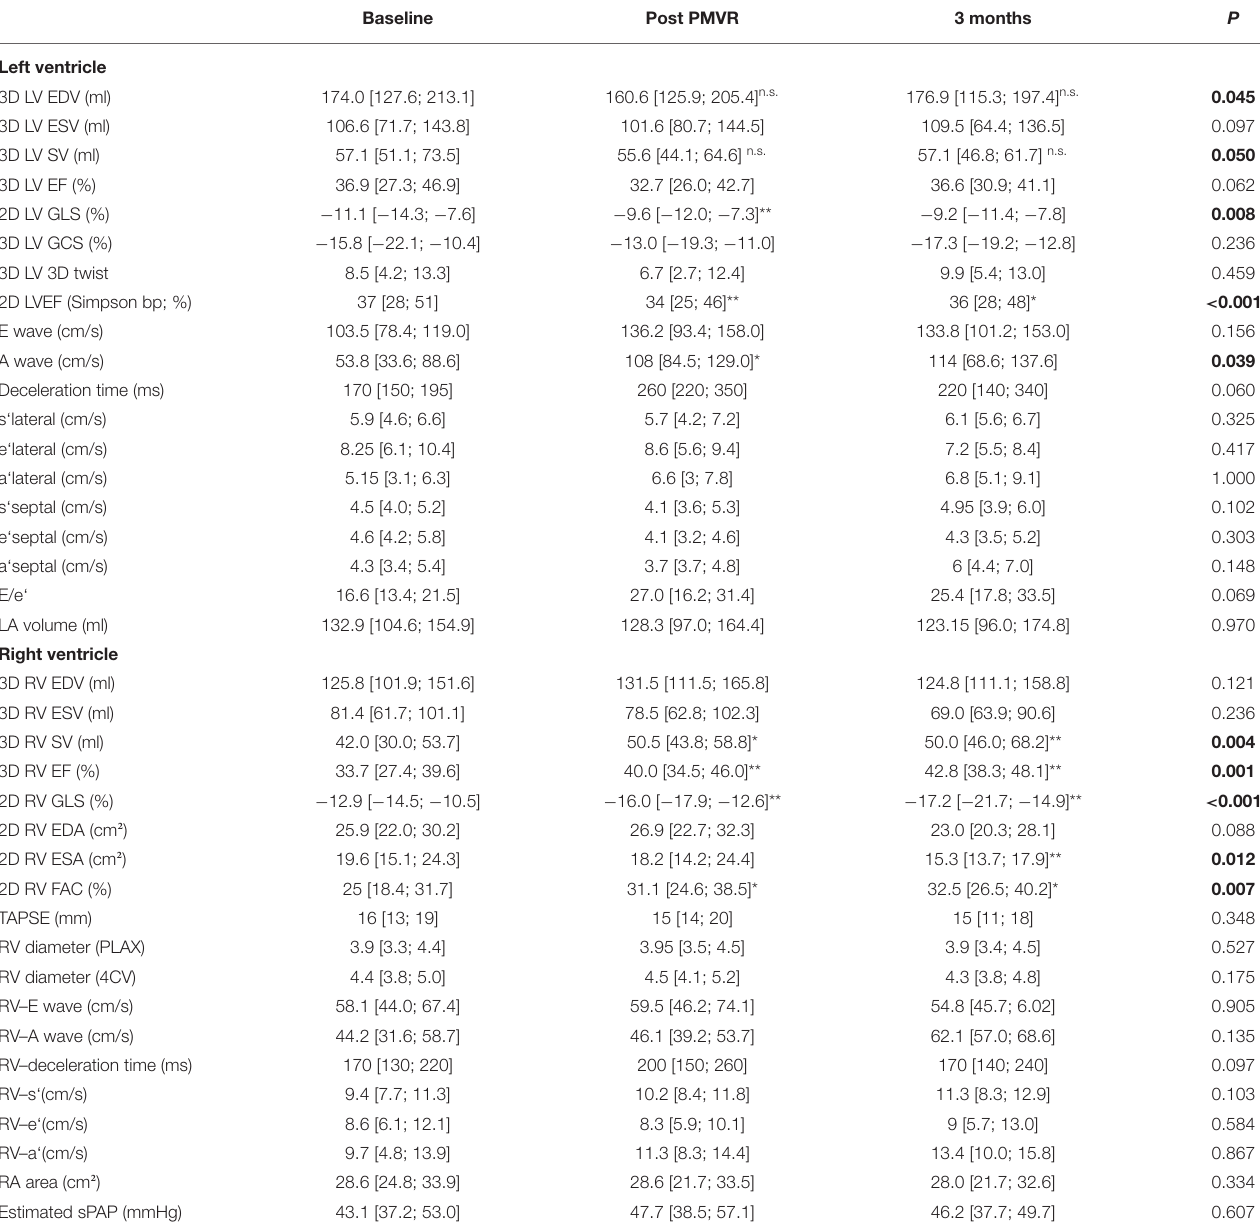
TABLE 2 | Echocardiographic analyses of LV and RV parameters at baseline, dismission (Post PMVR), and 3 months after percutaneous mitral valve repair (Data presented as inter quartile range).